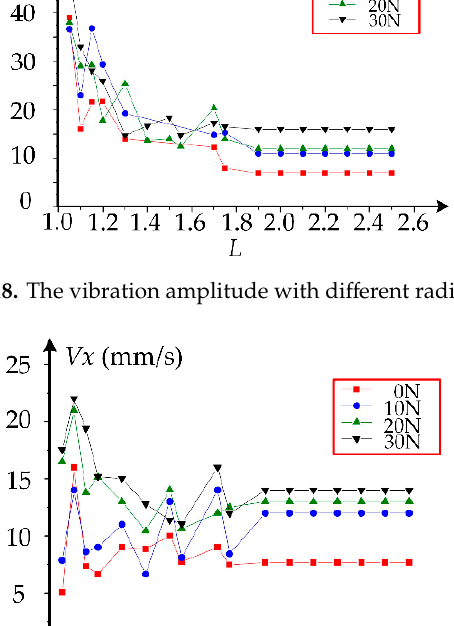
Figure 18. The vibration amplitude with different radial loads.